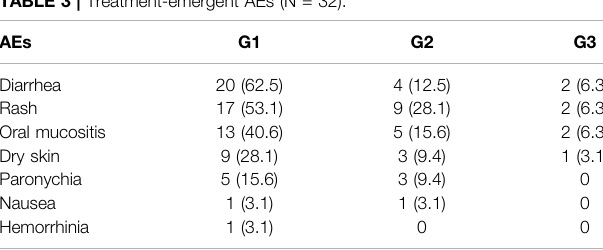
TABLE 3 | Treatment-emergent AEs (N =